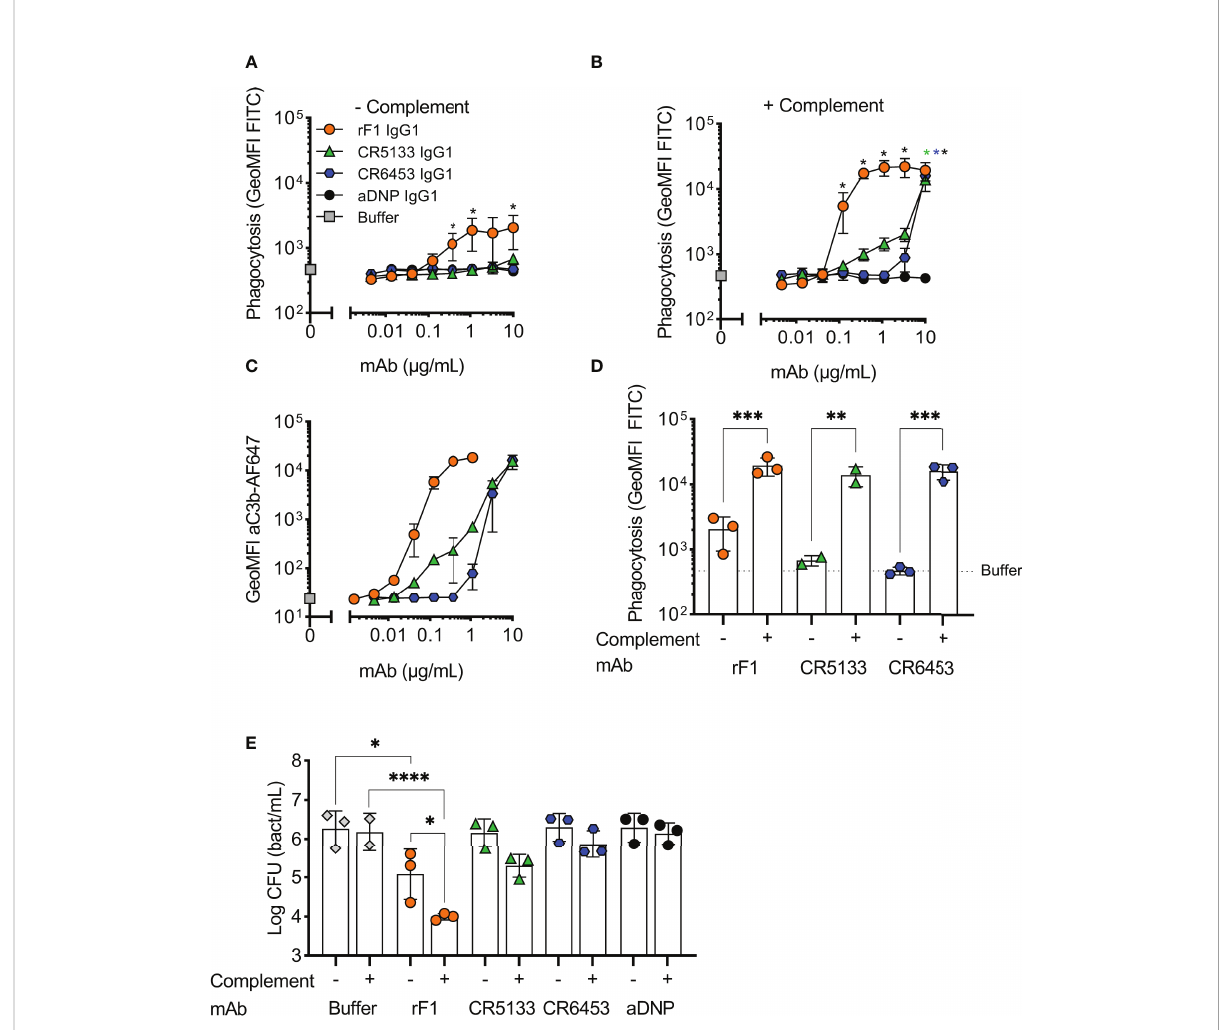
FIGURE 2 Activation of the complement system greatly enhances phagocytosis and killing with mAbs. (A,B) Phagocytosis of S. epidermidis ATCC 14990 by human neutrophils ((t=15 min), MOI 10:1) in (A) absence or (B) presence of complement. FITC labelled bacteria were incubated in (A) RPMI-HSA or (B) 1% IgG/IgM-depleted normal human serum ( D NHS) supplemented with a concentration range of rF1, CR5133, CR6453, aDNP IgG1 or buffer. Phagocytosis was quanti fi ed by fl ow cytometry and plotted as FITC GeoMFI of the neutrophils population. The gating strategy at 1